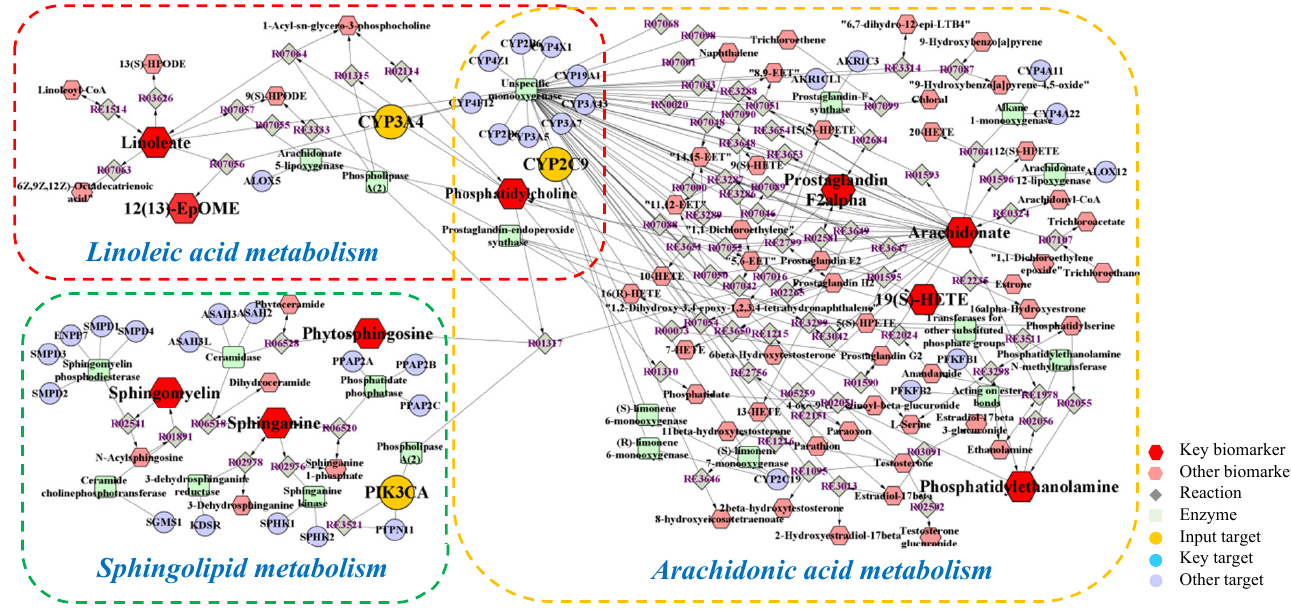
Figure 9. The compound-reaction-enzyme-gene networks of the key metabolites and targets. The red hexagons, grey diamonds, green round rectangle, purple circles and orange circles represent the active compounds, reactions, proteins, genes and hub genes, respectively. The key metabolites, proteins and genes were magnified.